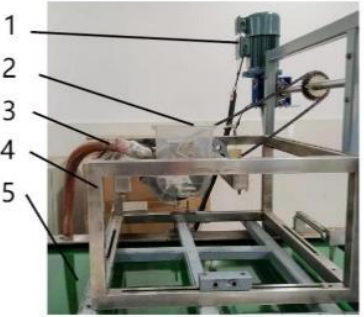
Figure 13. Seeding performance experimental device: 1. Motor; 2. Seed-metering device; 3. Negative pressure air tube; 4. Table frame; and 5. conveyor belt.